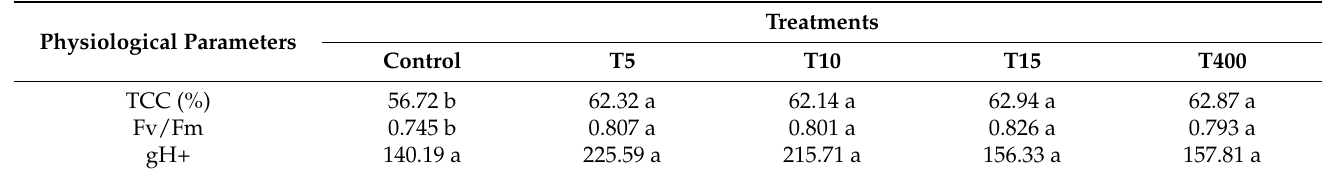
Table 7. Physiological parameters in coffee arabica (cultivar Catuai Vermelho IAC-44) under fungicide treatments for prevention of diseases, applied using a UAV and pneumatic sprayers, Marechal Floriano, ES, Brazil, 2021/2022 crop